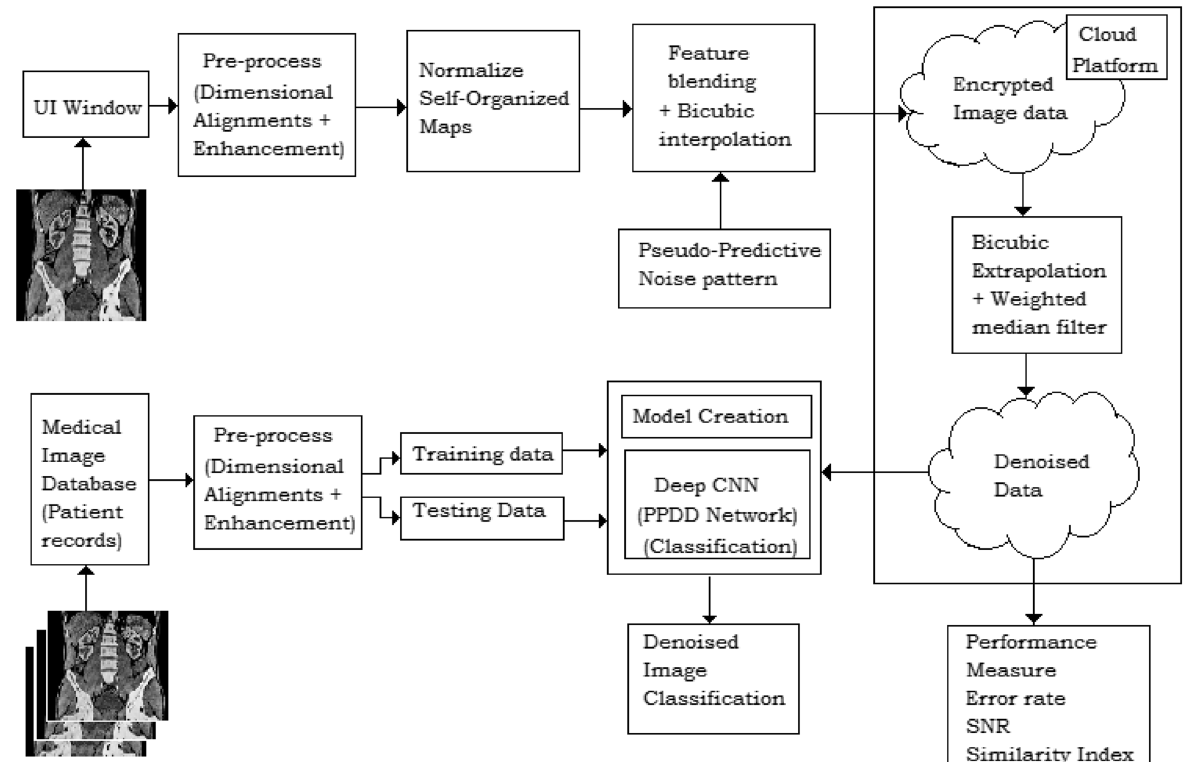
Fig. 3 System Design of Proposed Pseudo-Predictive Deep denoising network (PPDDN)